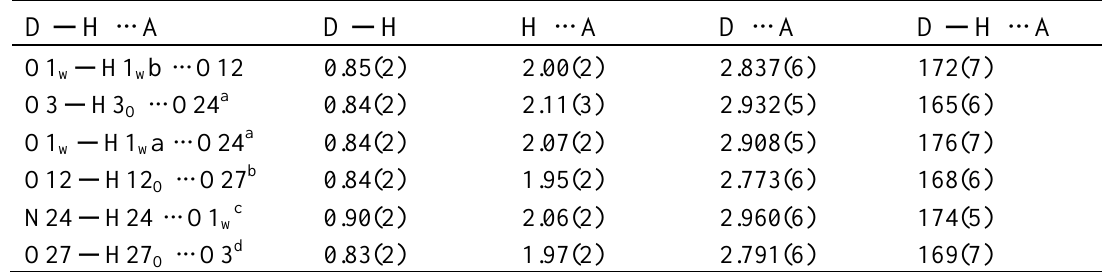
Table 2. Hydrogen bond lenghts (Å) and angles (°) of 3 .